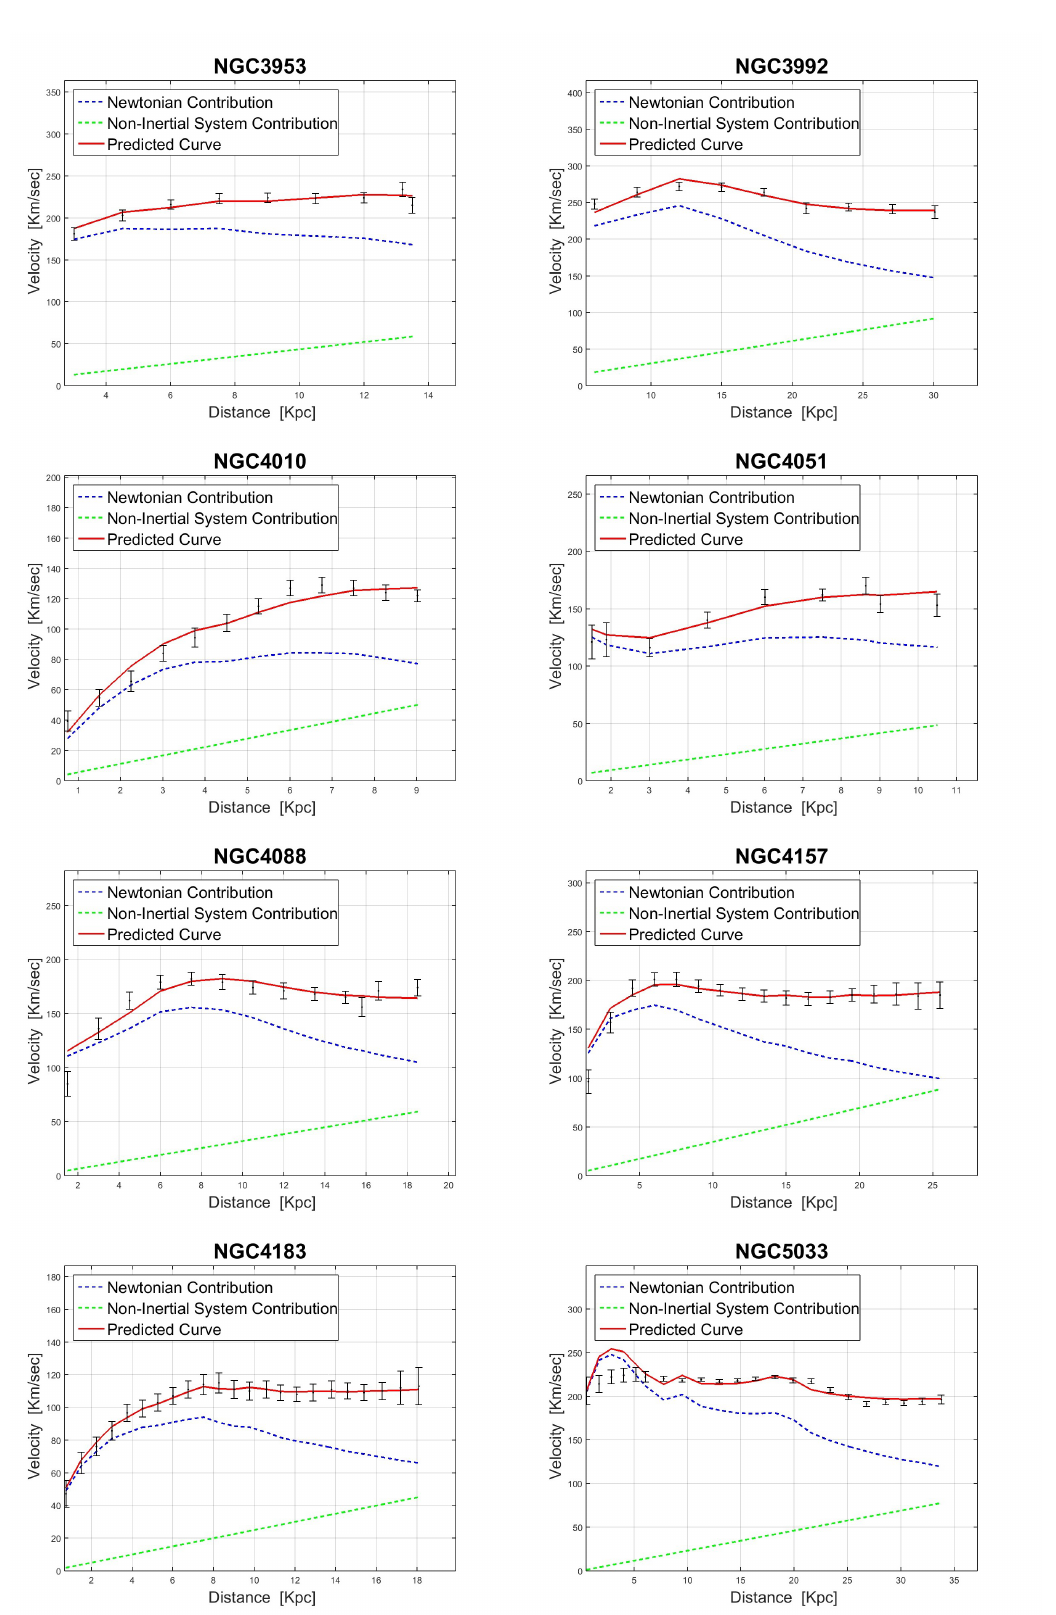
Figure 4. RCs for the different galaxies are presented. In each panel one can see the measured values (black error bars) together with the predicted curve (red line). The dashed blue curve corresponds to the Newtonian term v k ( r ) while the dashed green line corresponds to the linear correction term ω r